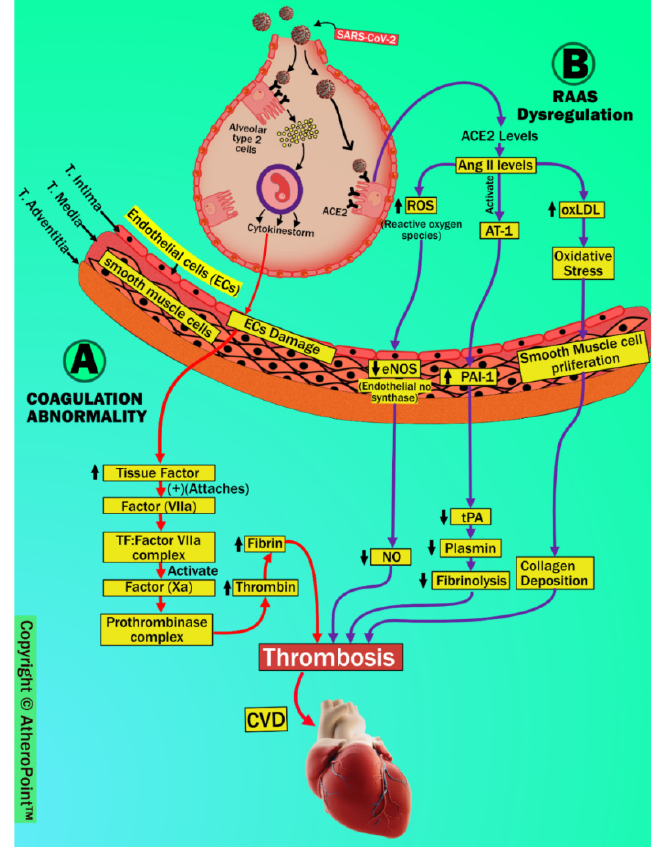
Figure 9. COVID ‐ 19 ‐ induced cardiovascular implications. (Original image, AtheroPoint™ LLC, Ro ‐ Figure 9. COVID-19-induced cardiovascular implications. (Original image, AtheroPoint™ LLC, seville, CA, USA) ( A ): Coagulation Abnormality, ( B ): RAAS Dysregulation. Roseville, CA, USA) ( A ): Coagulation Abnormality, ( B ): RAAS